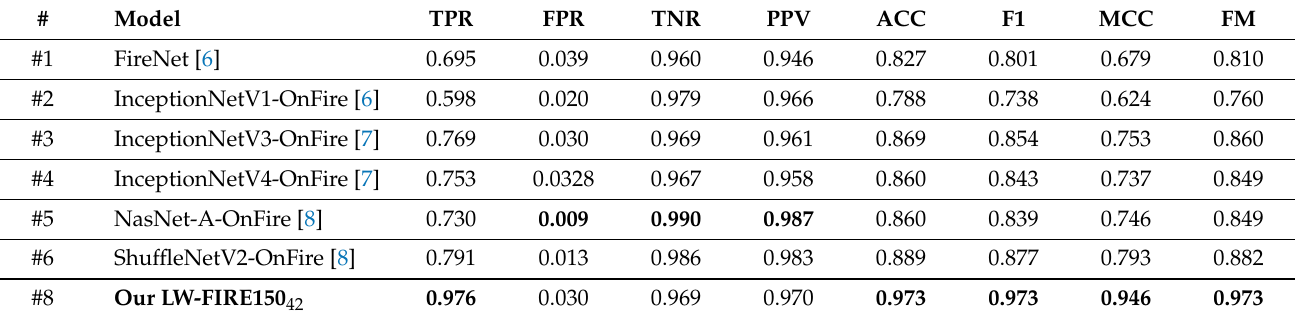
Table 8. Comparison with the state of the art on the dataset presented in this paper ( N =